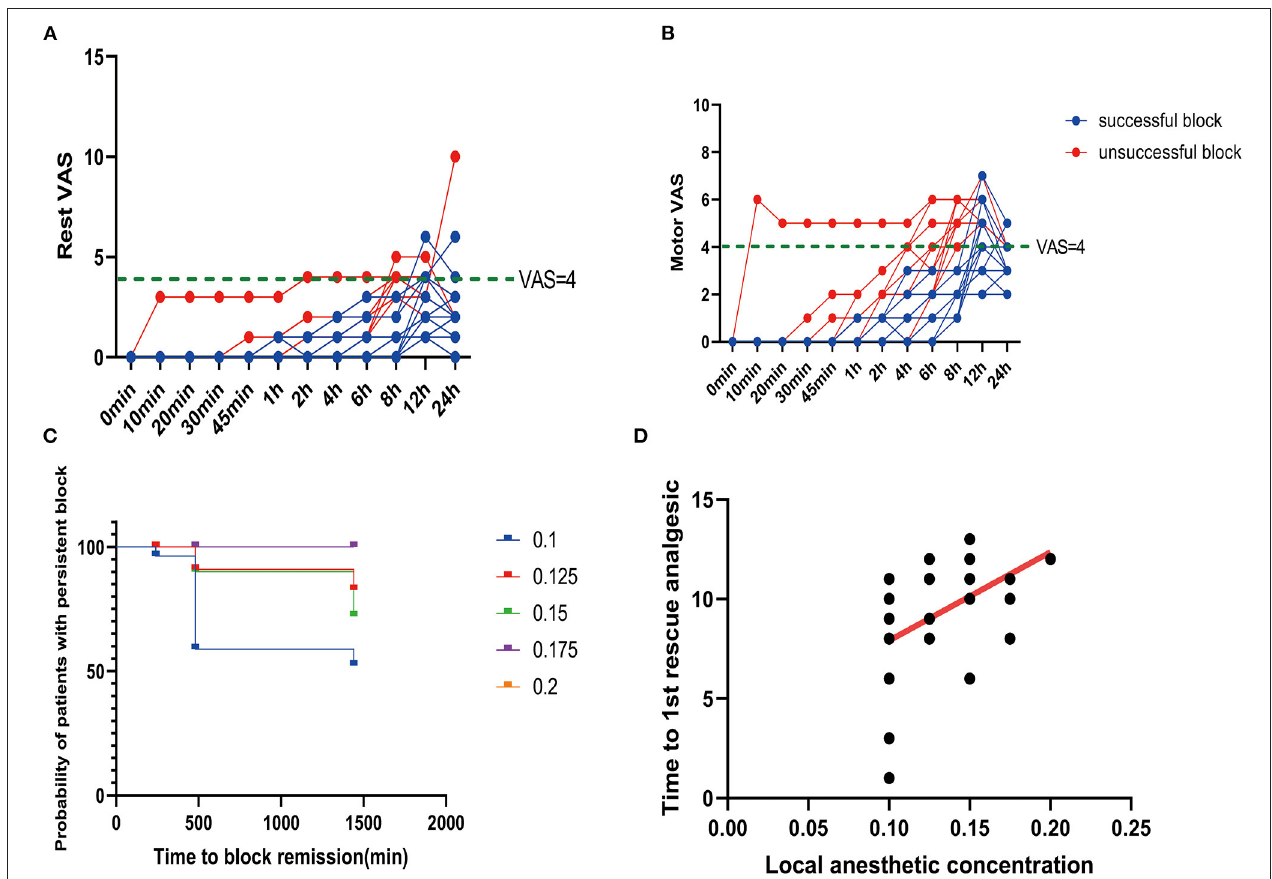
FIGURE 4 | Postoperative pain scores. (A) Rest pain score 24h after surgery. (B) Motor pain score 24h after surgery. (C) Duration of the sciatic nerve block with different concentrations of ropivacaine. (D) Correlation between ropivacaine concentration and time to the first rescue analgesic in sciatic nerve block.